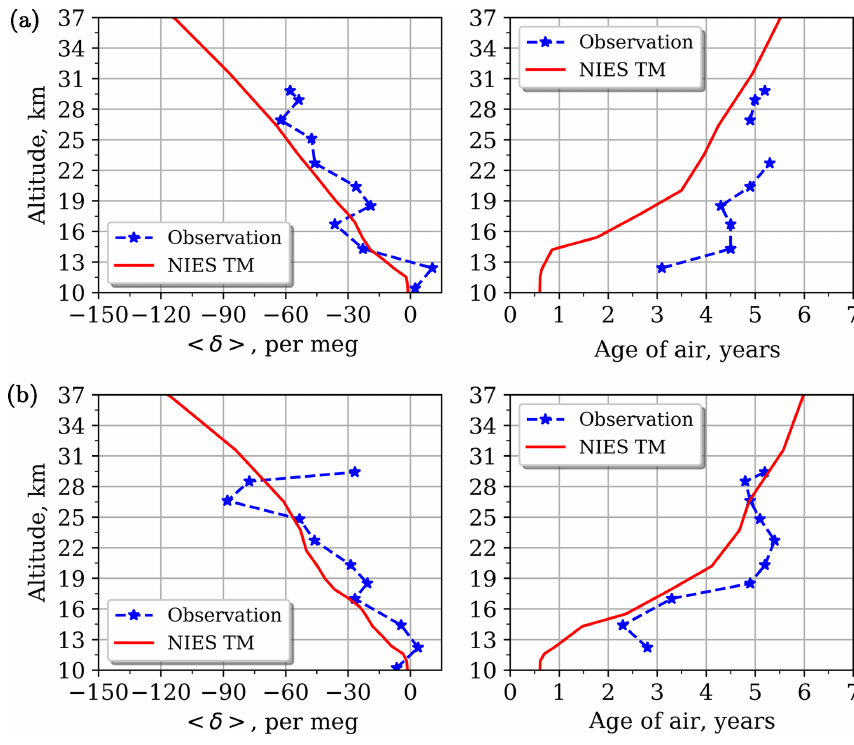
Figure 7. Same as Fig. 5 but over the Syowa station for 3 January 1998 (a) and 5 January 2004 (b)